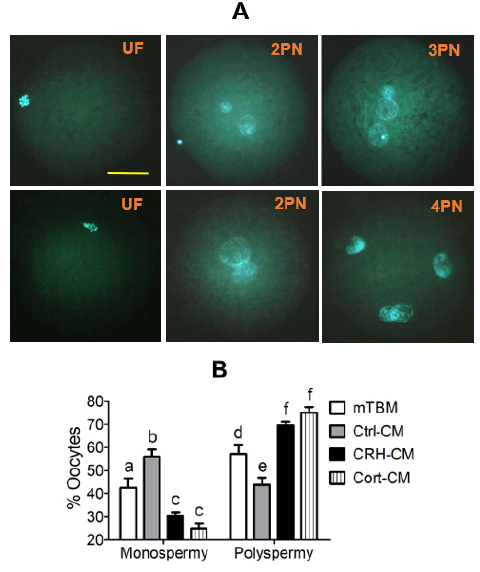
Figure 4. Fertilization of pig oocytes in modified Tris Buffer Media (mTBM)-Conditioning Media (mTBM-CM) conditioned with corticotrophin-releasing hormone (CRH)- or cortisol (Cort)-pre- treated oviduct epithelial cells (OECs). Panel ( A ) shows micrographs of unfertilized (UF) oocytes, and fertilized oocytes with two (2PN), three (3PN) or four pronuclei (4PN) as observed under a fluorescence microscope at a magnification of ×400 following Hoechst 33342 staining. The bar is 32 µm and applies to all images. Graph ( B ) shows percentages of oocytes with monospermy or poly- spermy after insemination of oocytes in mTBM alone, or in mTBM-CM conditioned with OECs without hormone pretreatment (Ctrl-CM), or with OECs pretreated with either CRH (CRH-CM) or cortisol (Cort-CM). a–f: Values with a different letter above the bars differ significantly ( p < 0.05).